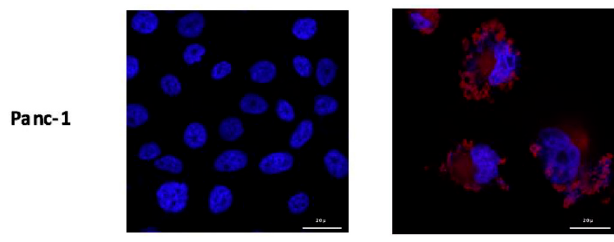
Figure 2. Localization of photosensitizer (PS)-2 in four PDAC cell lines. Cells are cultured with 1 µg/mL of PS2 during 24 h. Images are obtained using confocal microcopy 63× magnification.